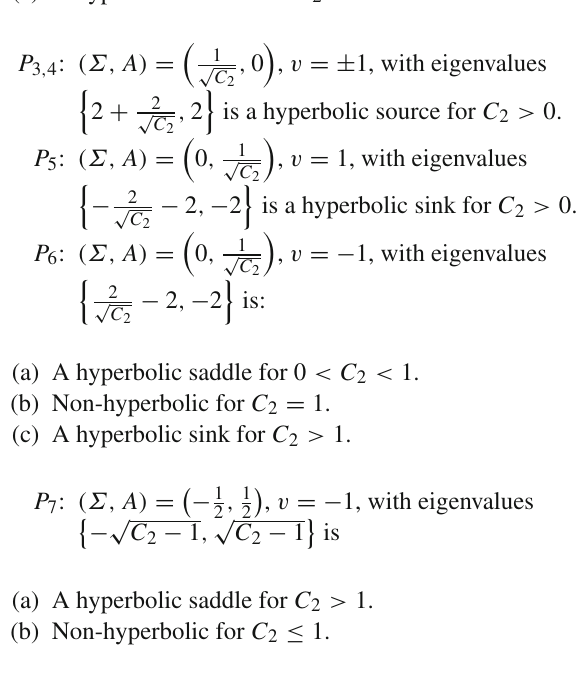
Fig. 2 Stability regions for SL − : v =